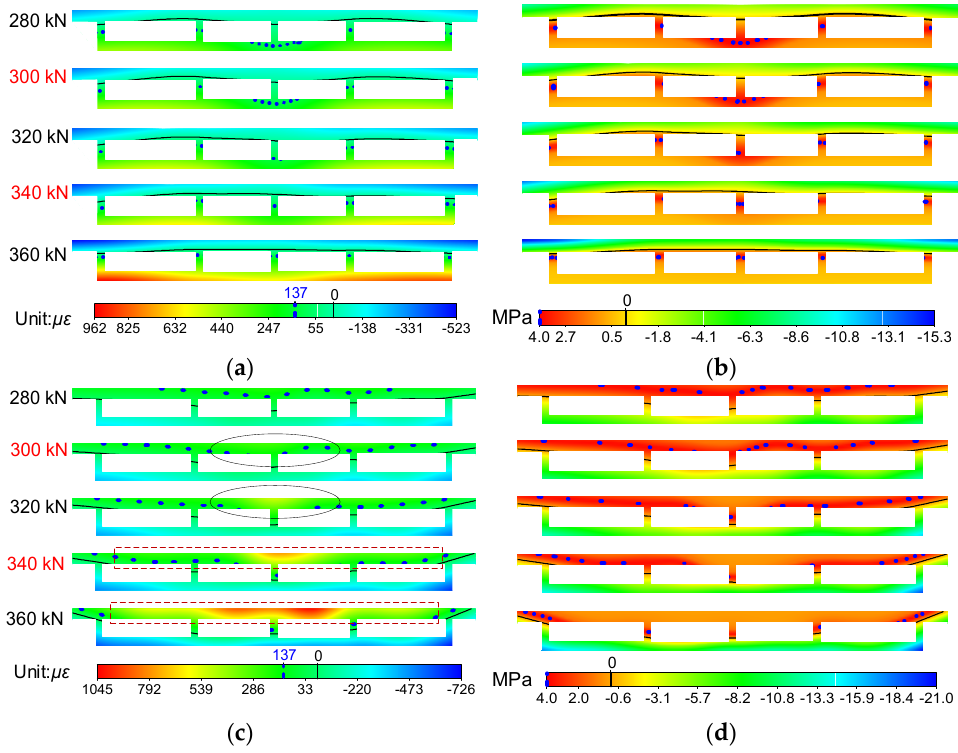
Figure 9. Strain and stress fields of the bridge model constructed by the NSF method: ( a ) strain fields of section A; ( b ) stress fields of section A; ( c ) strain fields of section B; ( d ) stress fields of section B.